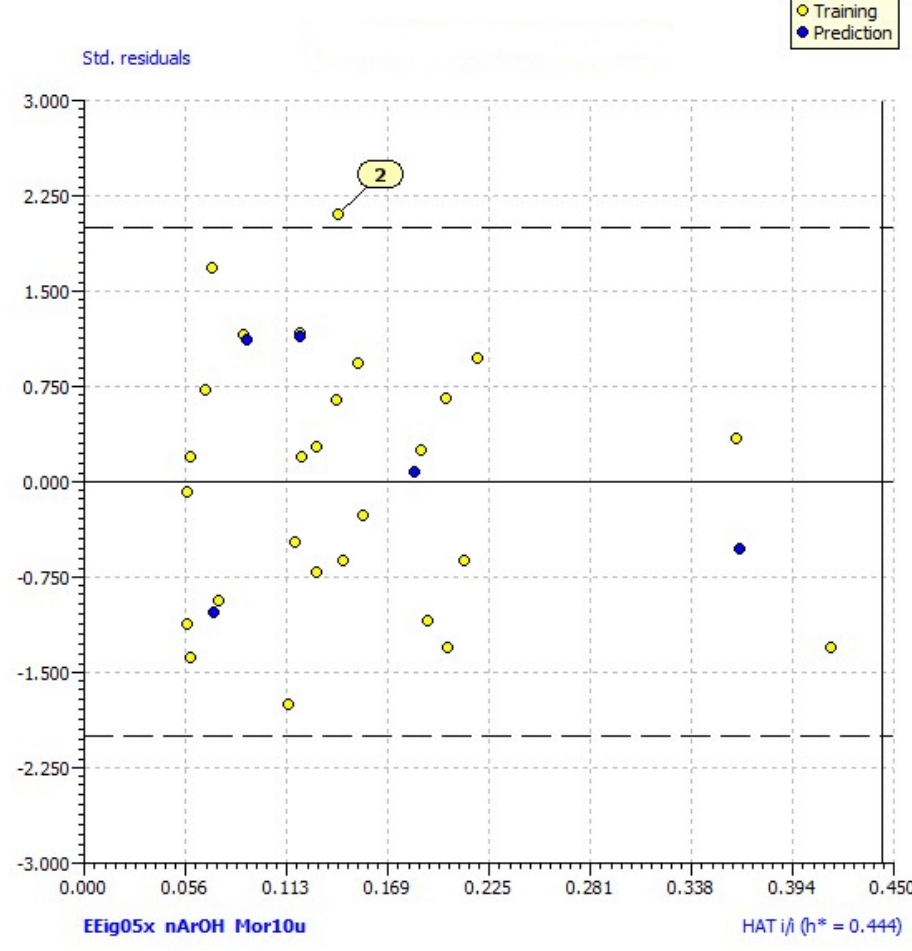
Figure 2. Williams plot (plot of standardized residuals vs. leverages ( h ) for each compound) of applicability domain of the QSAR model for hDPP III inhibition calculated by model 1. The warning leverage ( h* = 0.444) is defined as 3p ′ /n ( n is the number of training compounds, and p ′ the number of model adjustable parameters).